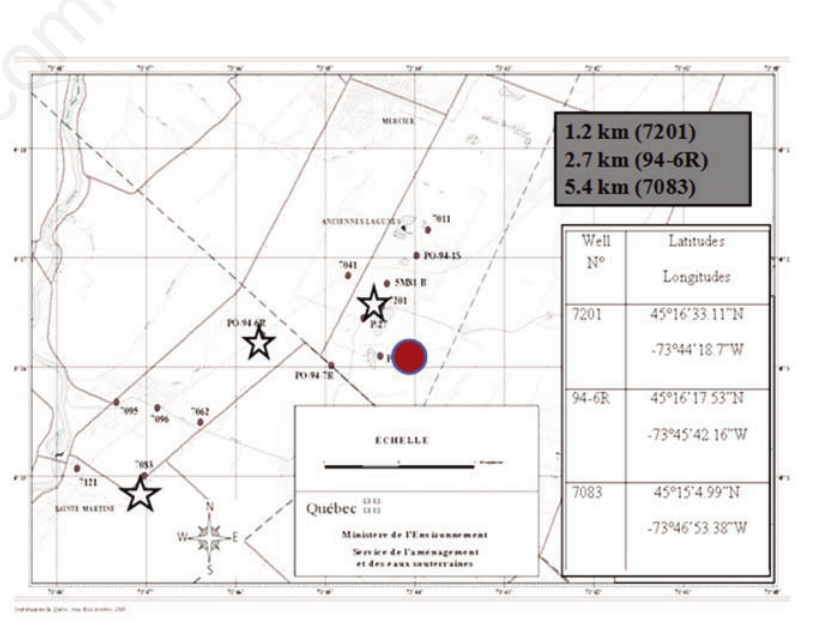
Figure 1. Map with sampling points around Mercier city in campaign may 2010. The wells exposure 7201, 94-6R and 7083 are located at distances (1.2, 2.7 and 5.4 km) from the lagoons. (Modified Map provided by the Ministry of Sustainable Development, Environment and parks of Quebec,